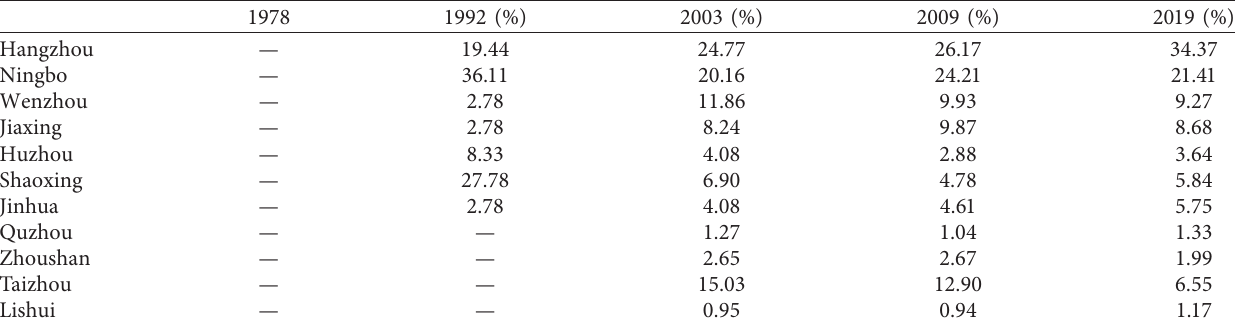
Table 3: Proportion of headquarters-branch enterprise linkages in cities in Zhejiang Province. 1978